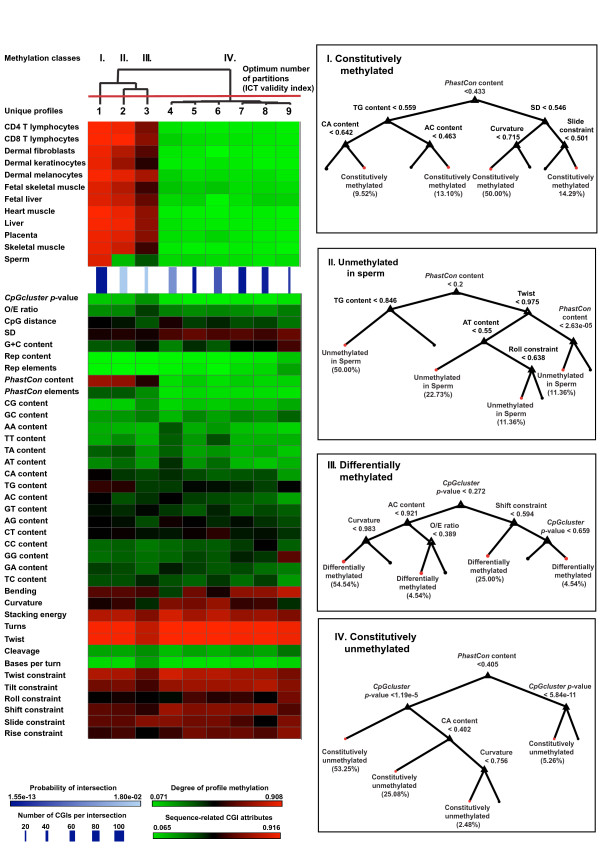
Linking clusters and Feature selection of new methylation classes. Summarization and feature selection of CGI profiles. A) Identification of 9 CGI profiles by linking CGI sequence attribute clusters (lower left corner) and methylation clusters (upper left corner) by the probability of the intersection (PI), which is calculated based on the hypergeometric measurement (blue color). The attributes were normalized within the colourmap intervals. Notably, the relations are built based on the PI (line color; dark blue: low p-value; light blue: high p-value), which substantially differs from the typical support of intersection measurement (line weight; thin: few; tick: many). For example, the fifth relation (5th column from left) is supported by just ~40 observations (thin line) but most of the CGI sequence attribute observations correspond to the 4th methylation class and only few belong to others classes. This approach can generate cohesive relations even if they aren't highly supported. The nine methylation profiles are summarized by similarity of their prototypes, constituting 4 final methylation classes (I-IV). These classes were used to label all CGI sequence attributes observations. B) Feature selection for each class based on the dataset labeled in A). This process has been carried out locally by using decision trees (Matlab) where the desired class (labeled read leaf) was distinguished from all of the others (unlabeled black leaf).